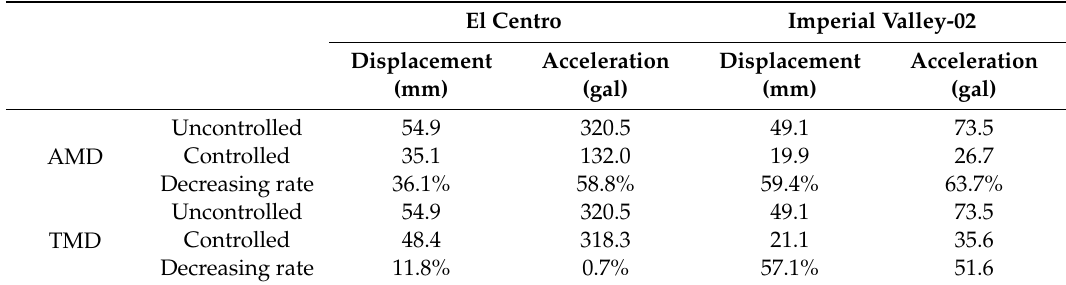
Table 4. Analytical results for the bridge model with each